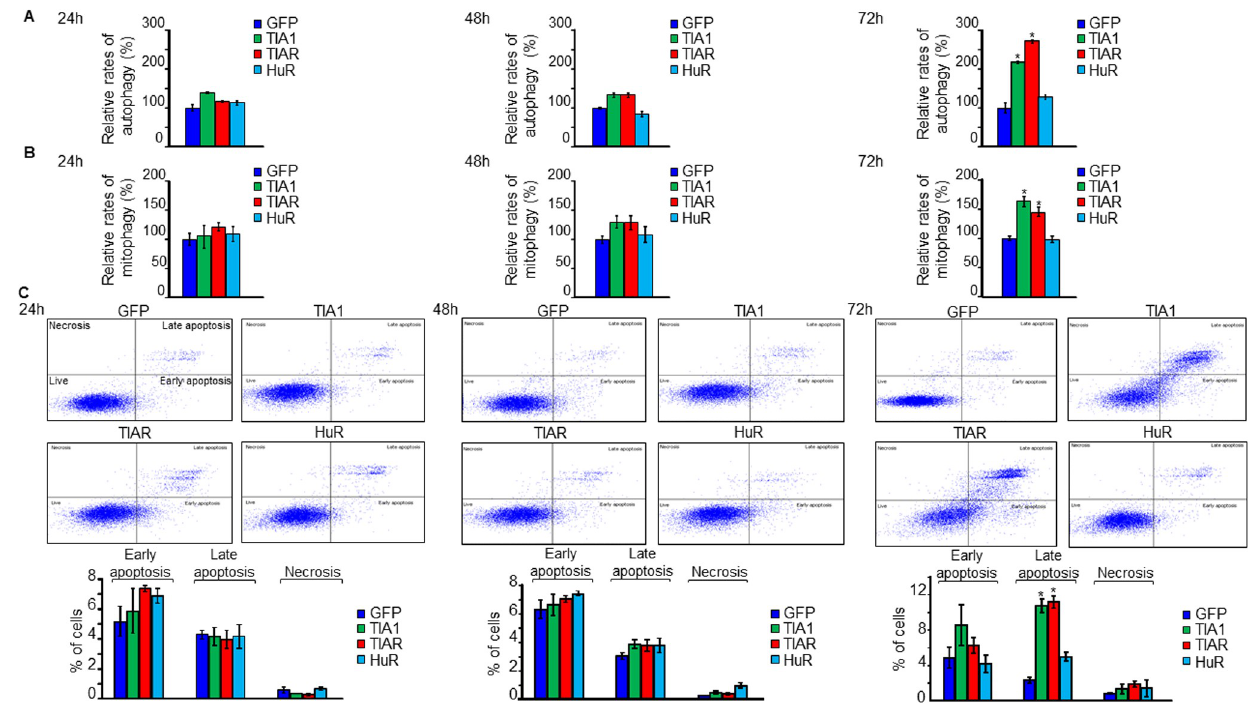
Fig 6. Analysis of autophagy, mitophagy, and apoptosis in RBP-expressing cells for 24–72 hours. (A) Autophagy analysis. Cell lines were transfected with GFP-LC3B-RFP plasmid, visualized by confocal microscopy and quantified. Histograms represent the sum of autophagosomes and autolysosomes estimated as yellow and free red dots per cell, respectively. The represented values were normalized and expressed as percentage relative to the GFP control. (B) Mitophagy analysis using mitochondrial Keima probe. Cell lines were transfected with the mt-Keima-expressing plasmid, visualized by confocal microscopy and counted. Histograms show normalized red/green mt-Keima signals. The represented values were expressed as a percentage relative to the GFP control. (C) Rates of cell death by apoptosis for 3 days. Quantification of apoptosis rates was carried out by flow cytometry. All the represented values are means ± SEM (n = 3; � P <